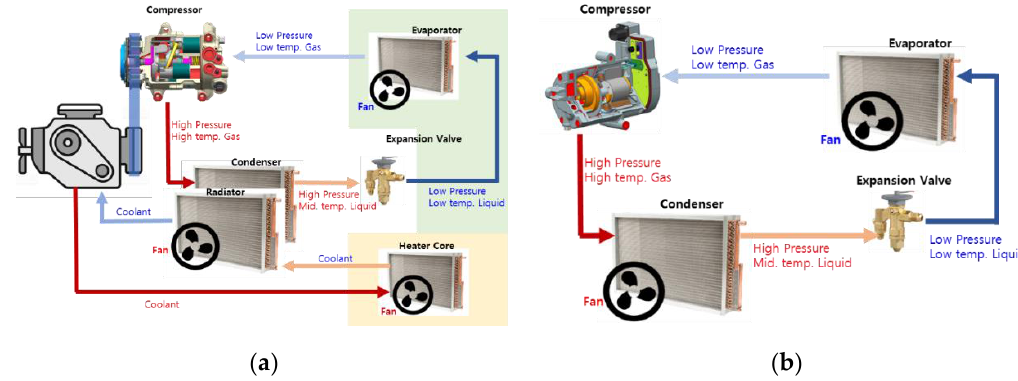
Figure 2. Diagram of the heating, ventilation and air conditioning (HVAC) system on the vehicle: ( a ) internal combustion engine (ICE) vehicle and ( b ) battery electric vehicle (BEV).